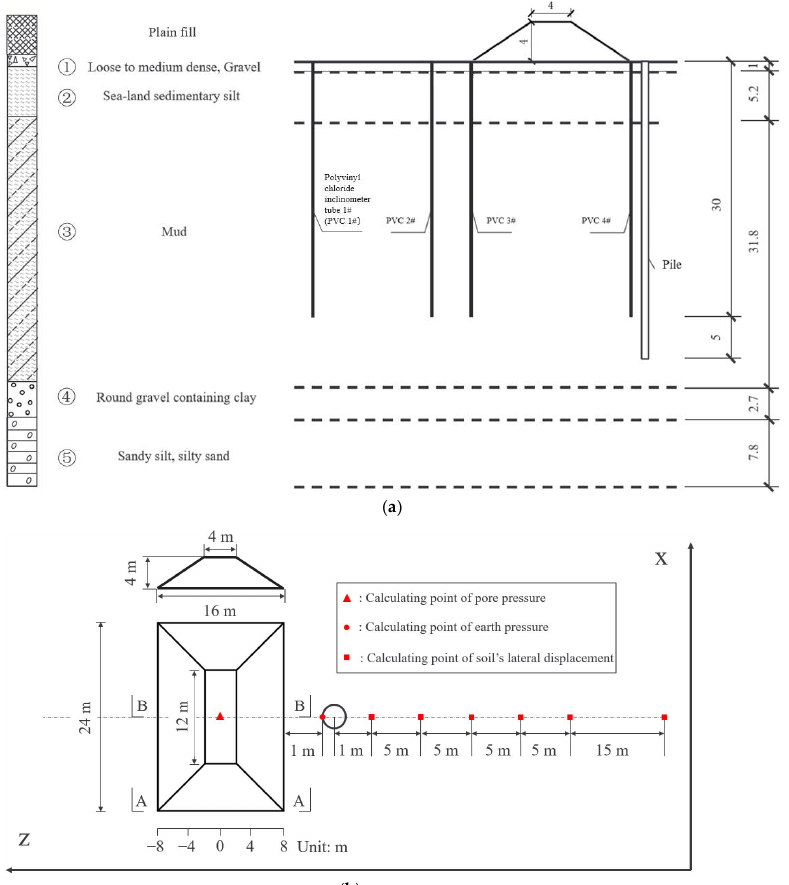
Figure 2. The layout of the field test and the positions calculated in the numerical model: ( a ) profile view; ( b ) plan view. (Unit: m).